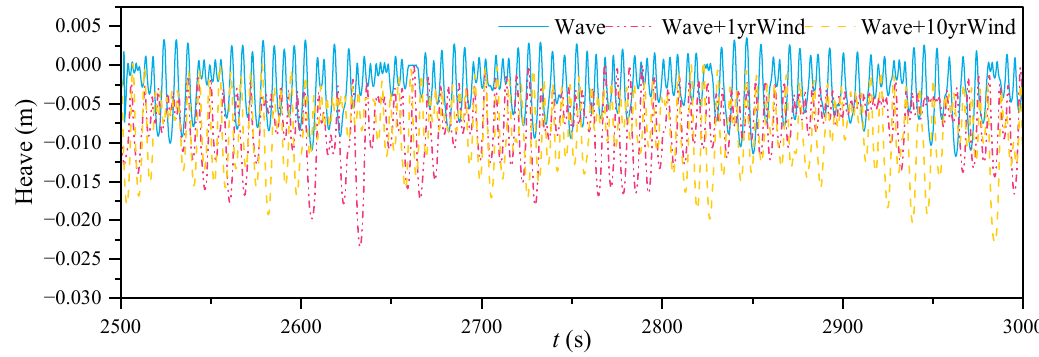
Figure 19. Heave response under wave load and current load.